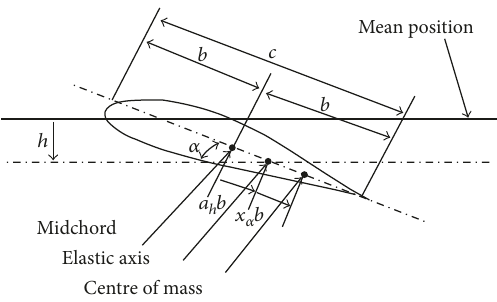
Figure 1: Sketch of an airfoil oscillating in pitch ( α ) direction with respect to the elastic axis and in plunge ( h ) direction measured from the mean position